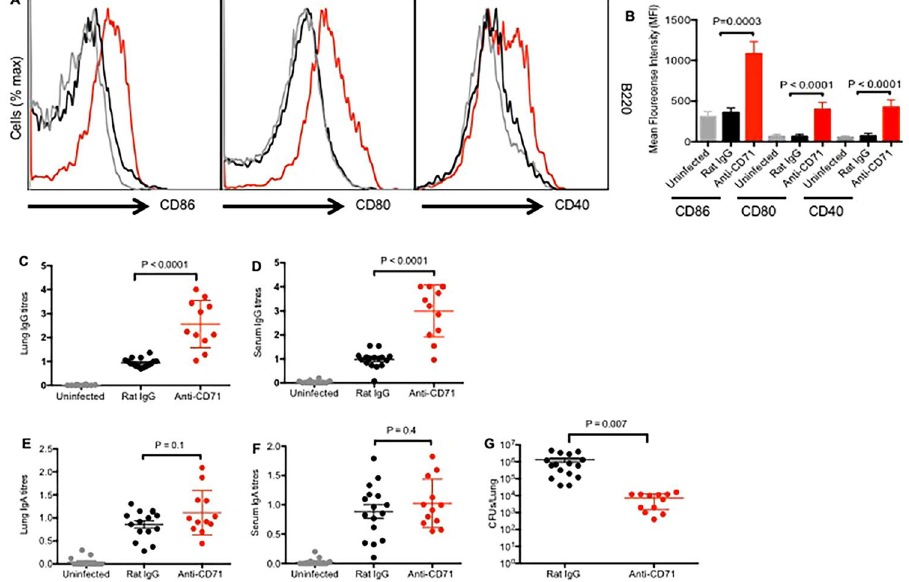
Figure 4. CD71 + cells inhibit B. pertussis -specific antibody response. ( A ) Relative CD86, CD80, and CD40 expression by B220 cells from the lungs at day 2 post infection, treated with anti-CD71 (red histograms gated on CD220 cells) or isotype control antibody (black histograms gated on CD220 cells) and uninfected mice (gray histograms gated on CD220 cells. ( B ) The mean fluorescent intensity for each parameter among the spleen CD220 cells from CD71 depleted mice was compared with isotype antibody treated or uninfected mice. ( C,D ) Anti- B. pertussis -specific IgG antibody detected in the lungs and serum respectively, ( E , F ) anti- B. pertussis - specific IgA antibody in the lungs and serum respectively were measured by ELISA as described in methods. ( G ) Recoverable bacteria in the lungs of mice after infection with B. pertussis (5 × 10 6 CFUs) in control versus CD71 + cells depleted mice after re-infection. Each point represents data from an individual mouse, representative of three independent experiments. Bar, mean ± one standard